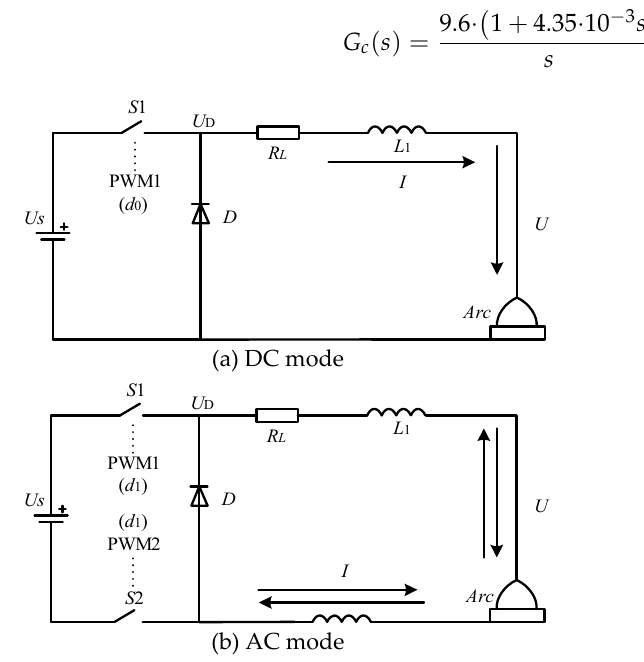
Figure 9. Simplified block diagram. The closed-loop control system of the converter is shown in Figure 10, where G ( s ) is the transfer function from the duty cycle d ( s ) to the output I o ( s ), and G i ( s ) is the transfer function of the error between I o ( s ) and i g . G m ( s ) is the transfer function of the PWM pulse width modulation, H ( s ) is the transfer function representing the negative feedback current measurement network, and G v d ( s ) is the transfer function of the controller. The closed- loop system block diagram of the buck converter can be represented in a standard form,